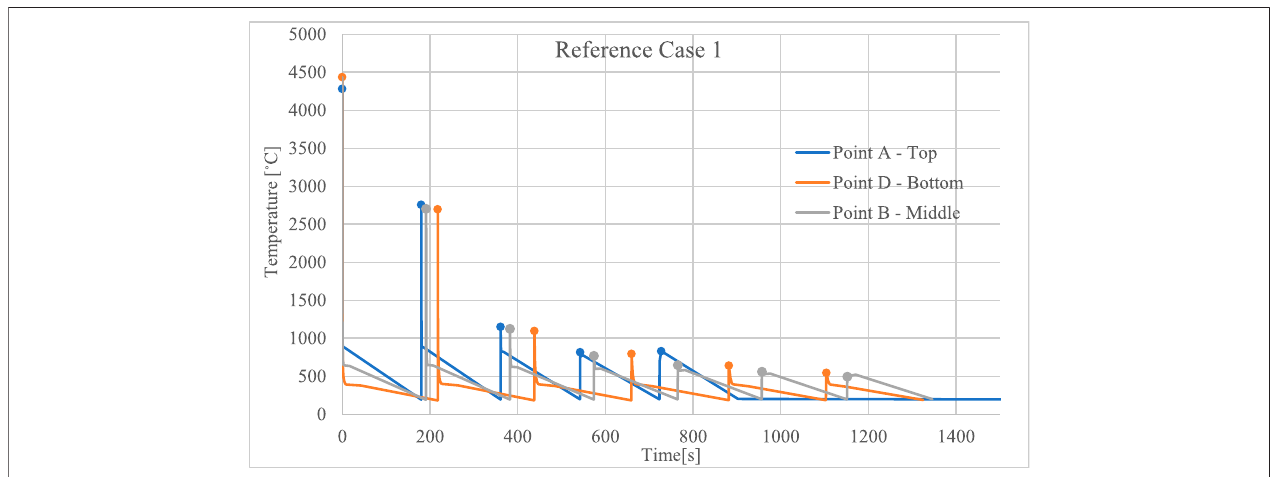
FIGURE 7 | First temperature peaks of points A and D for reference Case 1.